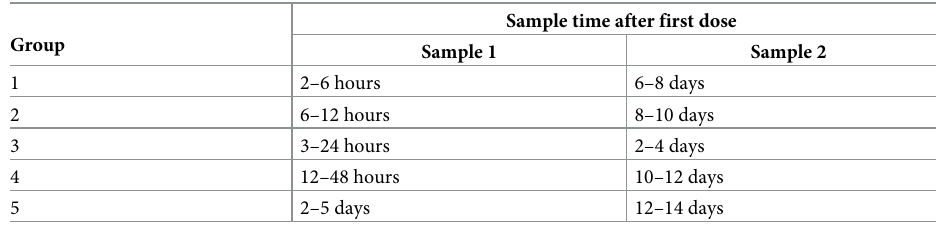
Table 1. Timing of blood samples in the 5